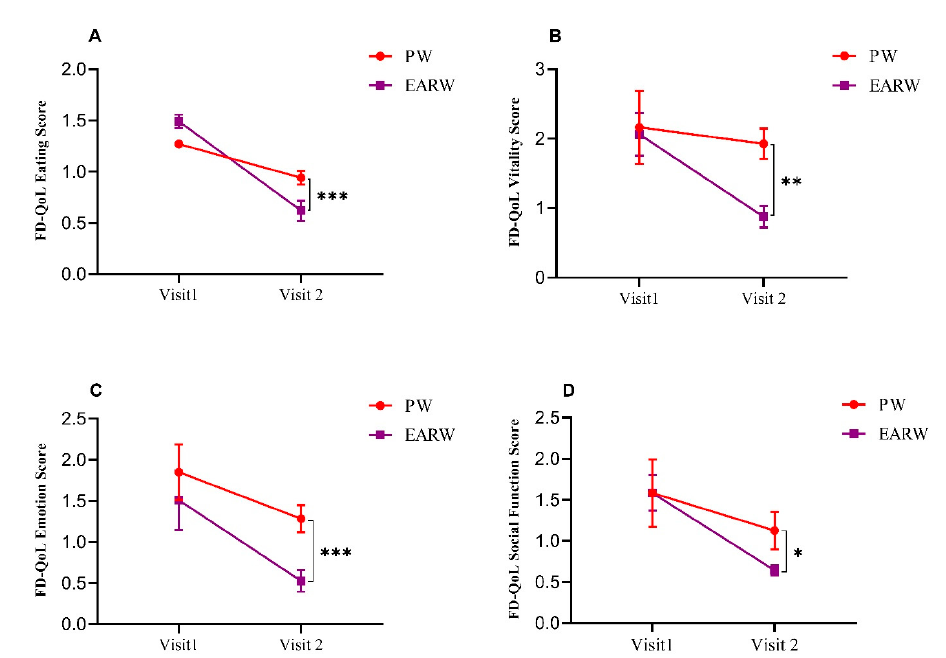
Figure 3. Drinking effects of EARW were assessed by using FD-QoL questionnaire in FD patients. Eating ( A ), vitality ( B ), emotion ( C ) and social function ( D ). Survey data were collected at baseline (visit 1) and after 6 weeks of intervention (visit 2). Data are presented as mean, SD, and p -value between two groups. Significant differences were analyzed using two-way ANOVA with Sidak’s multiple comparisons test. *** p < 0.001, ** p < 0.01, * p < 0.05. Abbreviations: GSRS: gastrointestinal symptoms rating scale; PW: purified water group; EARW: electrolyzed alkaline-reduced water group.